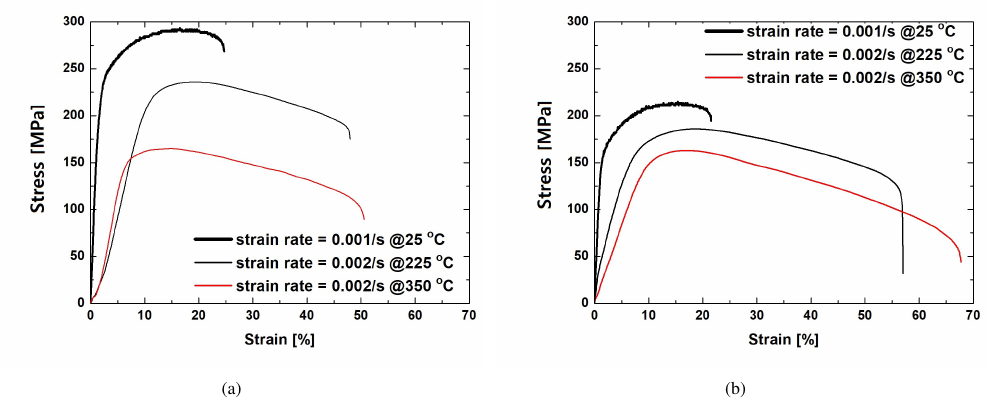
Figure 3. Tensile stress-strain curves of Mg–Al–Mn sheets at various temperatures and strain rates.